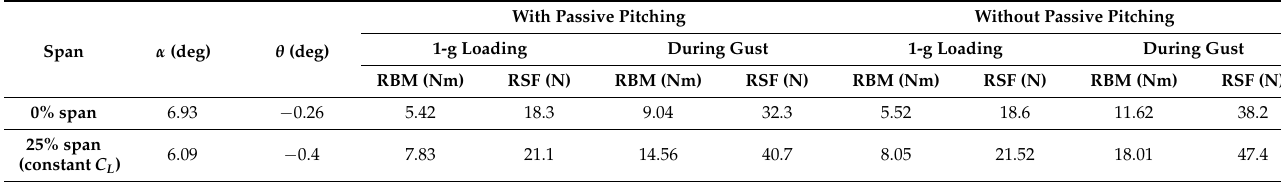
Table 2. Variation in RBM due to passive pitching